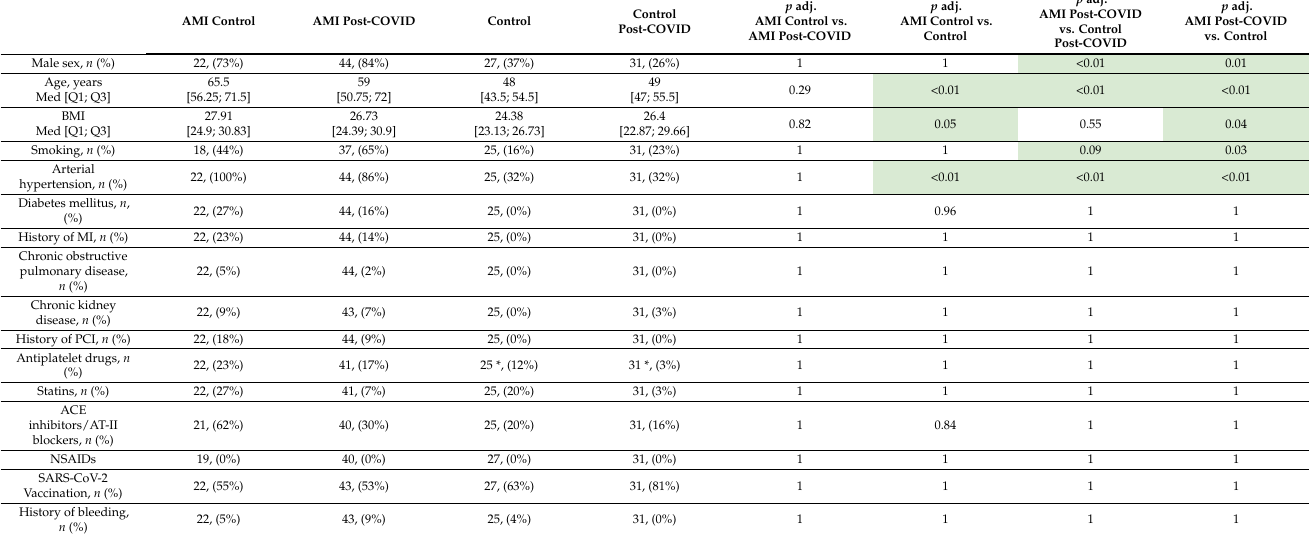
Table 1. Comparison of clinical data between study groups. BMI—body mass index, NSAID—non- steroidal anti-inflammatory drugs. Green: p adj. <